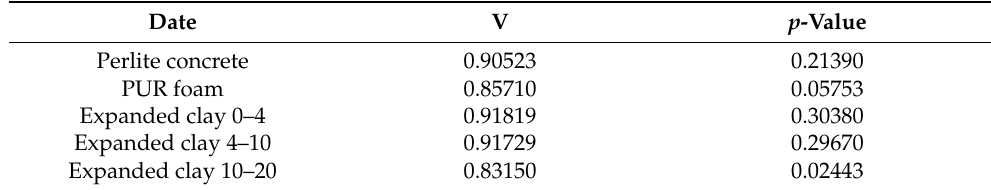
Table 2. Shapiro–Wilk test results for selected data series.